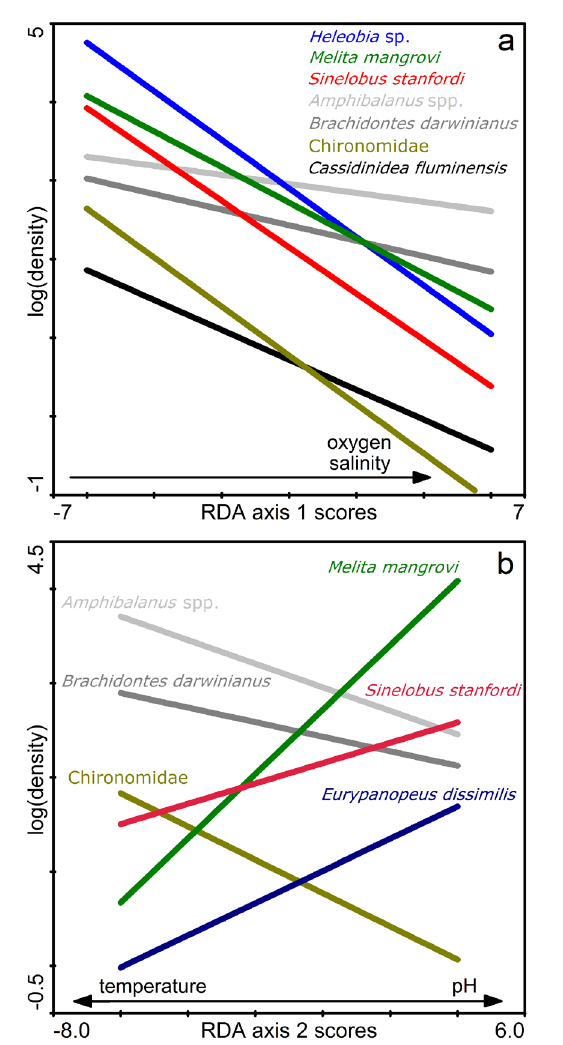
Figure 8. Relationships of the densities of the macrofauna benthic species associated to Mytilopsis leucophaeata and the suite of the environmental variables retrieved from RDA axes one (a) and two (b). Lines represent the generalized linear model (GLM) selected by the